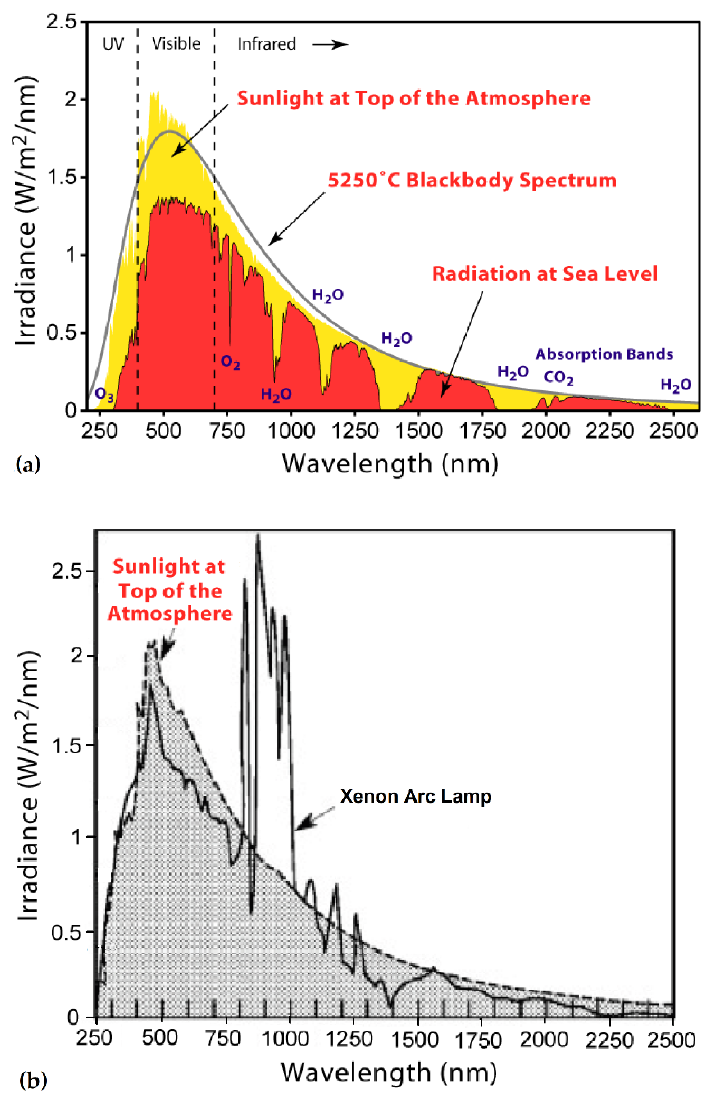
Figure 9. ( a ) Solar radiation spectrum for direct light at both the top of the Earth’s atmosphere (represented by yellow area) and at sea level (red area); ( b ) unfiltered radiation spectrum of xenon arc lamp and the sunlight spectral irradiance at top of the